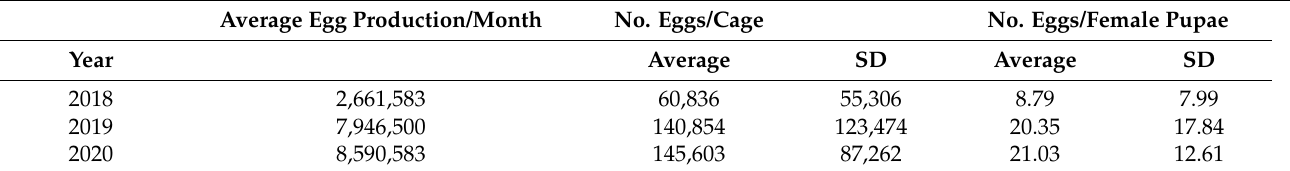
Table 3. Egg production parameters for three years of mass rearing of Aedes albopictus . Average Egg Production/Month No. Eggs/Cage No. Eggs/Female